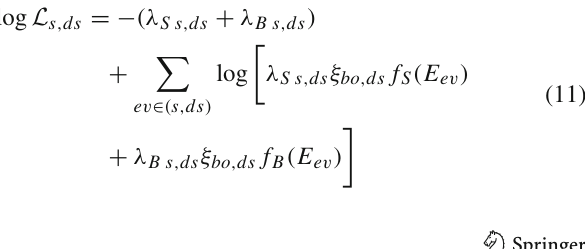
Table 3 Selected experimental signatures for DBD search on the 0 + excited state of 130 Xe in the 0 νββ (top) and 2 νββ (bottom) channel are listed. For each signature the corresponding Regions Of Interest (ROI, i.e. the applied selection cuts) are listed in terms of the ordered energy